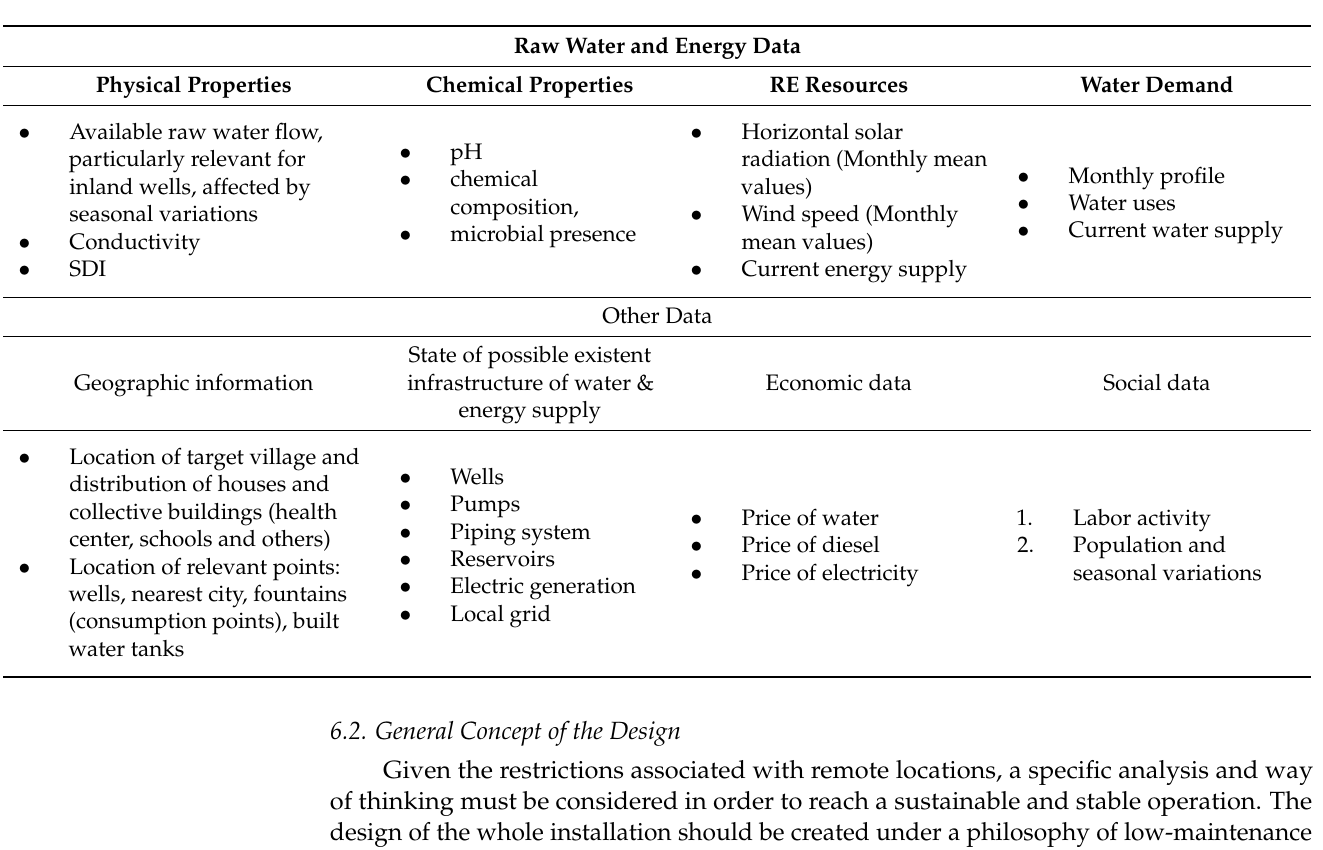
Table 6. List of the basic information to be